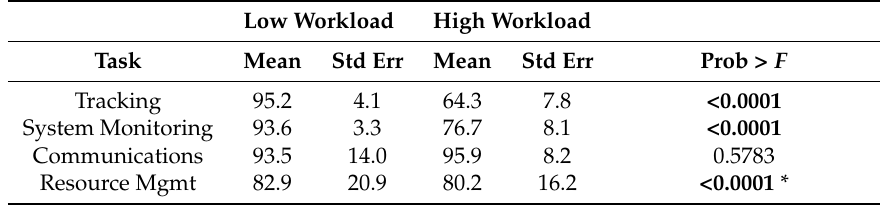
Table 1. Summary statistics for performance metrics and 2-factor ANOVA results evaluating if there is a difference in mean human performance between low and high workload by task. Bold denotes statistically significant results at the α = 0.05 level of